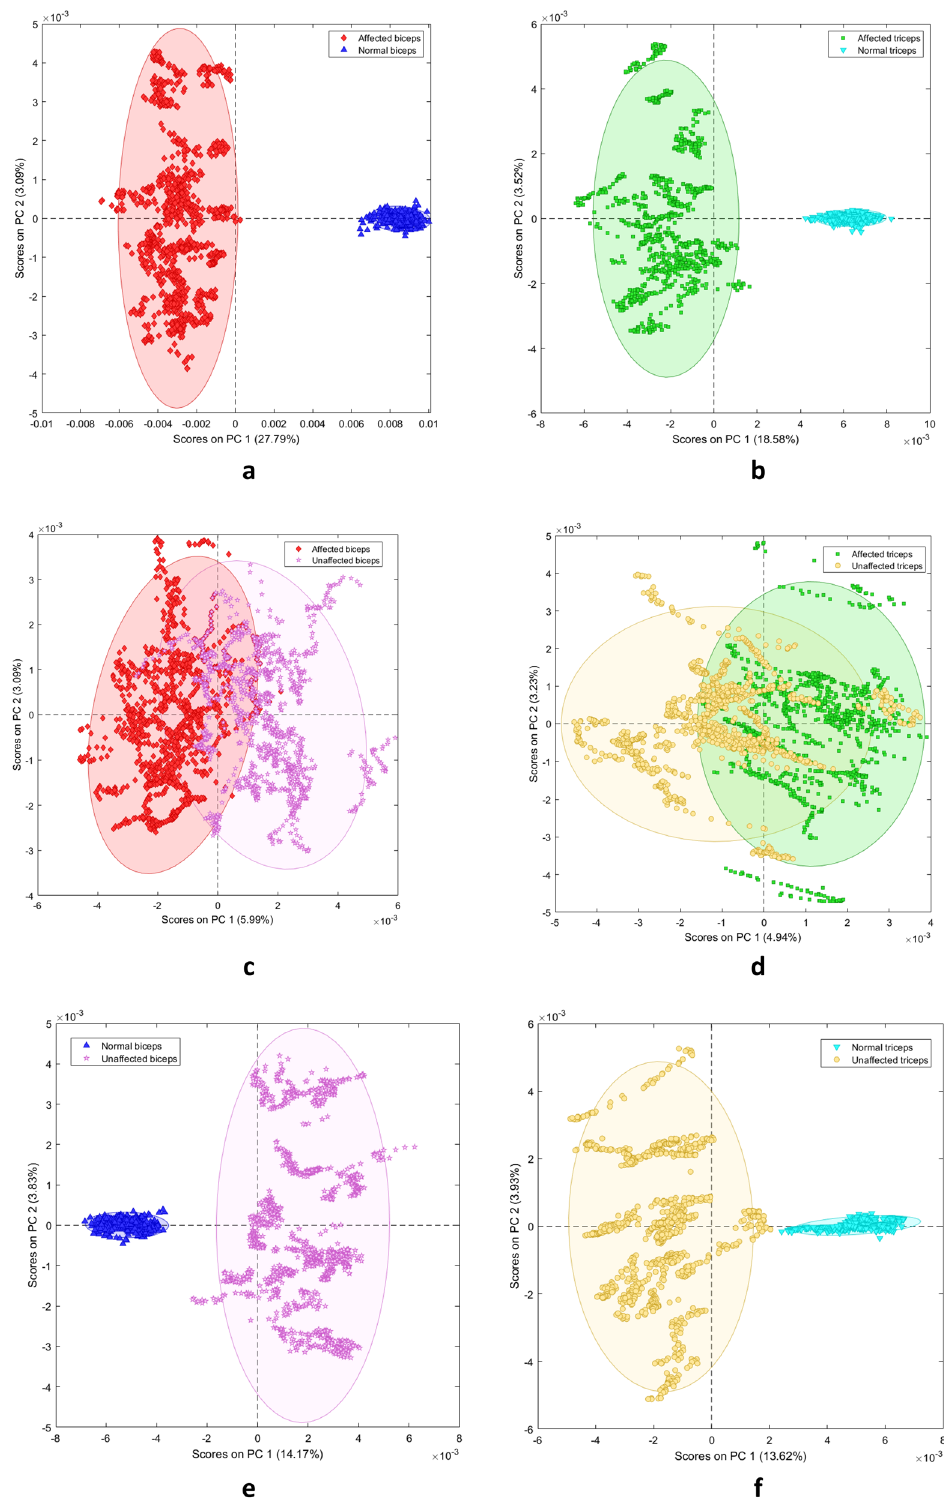
Figure 3. Principal component analysis score plots for (a) affected biceps spectra vs. normal biceps spectra; (b) affected triceps spectra vs. normal triceps spectra; (c) affected biceps spectra vs. unaffected biceps spectra; (d) affected triceps spectra vs. unaffected triceps spectra; (e) unaffected biceps spectra vs. normal biceps spectra; and (f) unaffected triceps spectra vs. normal triceps